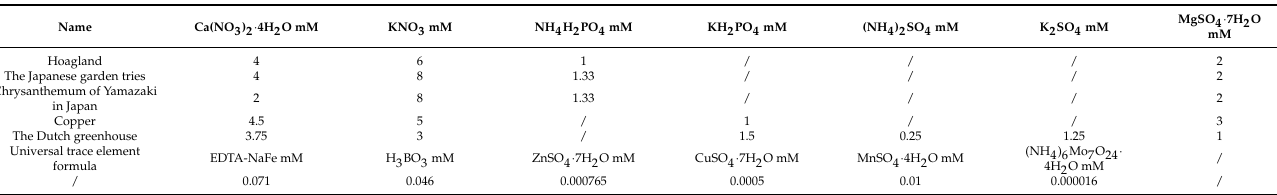
Table 3. General crop culture fluid